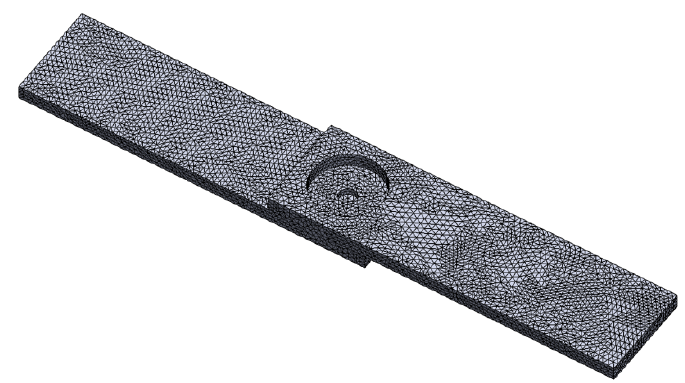
Figure 5. The contact conditions of the FEM and applied interface.